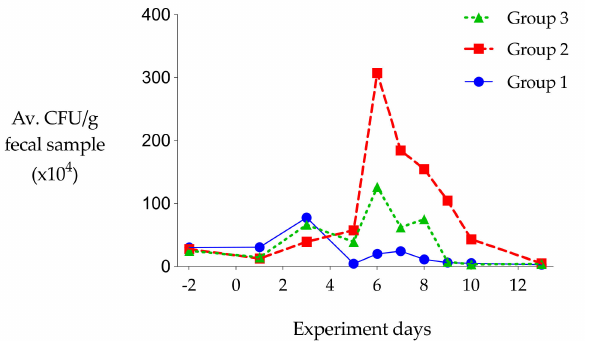
Figure 8. Bacterial load in fecal samples measured as CFU. The piglets were challenged on days 2 and 3. Peak fecal bacterial load was recorded on day 6 in groups 2 and 3, after which there was a progressive decline. Group 2 had lower CFU counts than group 3 and resolved quickly to the basal level (Group 1) on day 9. Group 1, negative control group (not infected); Group 2, positive group (infected and not treated); Group 3; test group (infected with F4 + ETEC and anti-FaeG Nanobodies on the surface of L. lactis added to the meals from day 0 to day